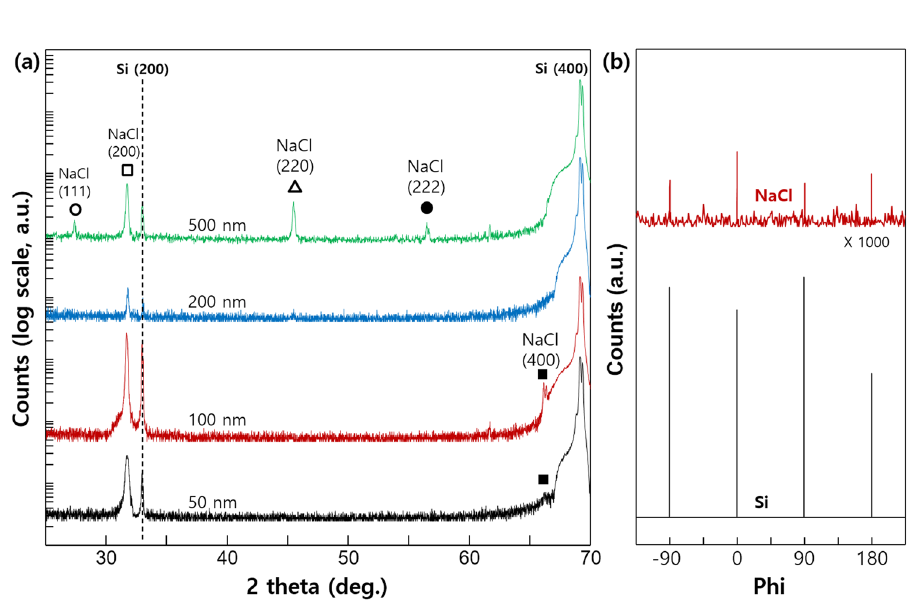
Figure 2. ( a ) XRD patterns of NaCl films grown on Si(100) substrates at different film thicknesses ( b ) Azimuthal diffraction scans across the off-normal NaCl {220} and Si {110} for 100 nm-thick NaCl film on Si(100)